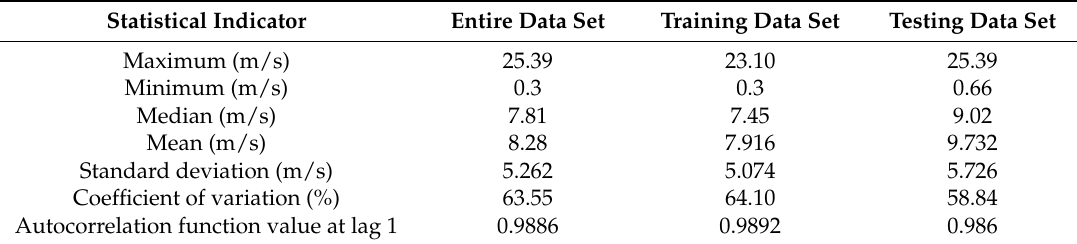
Table 1. Statistical information for each data